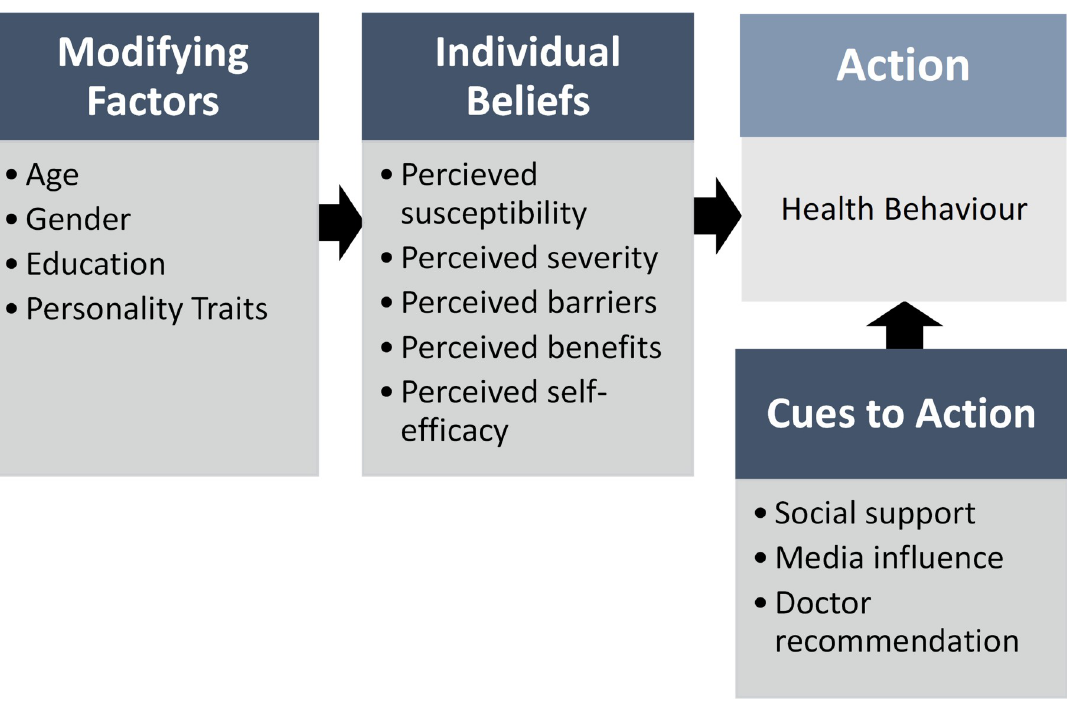
Fig 2. An overview of variables included in the Health Belief Model, used to predict uptake of a health